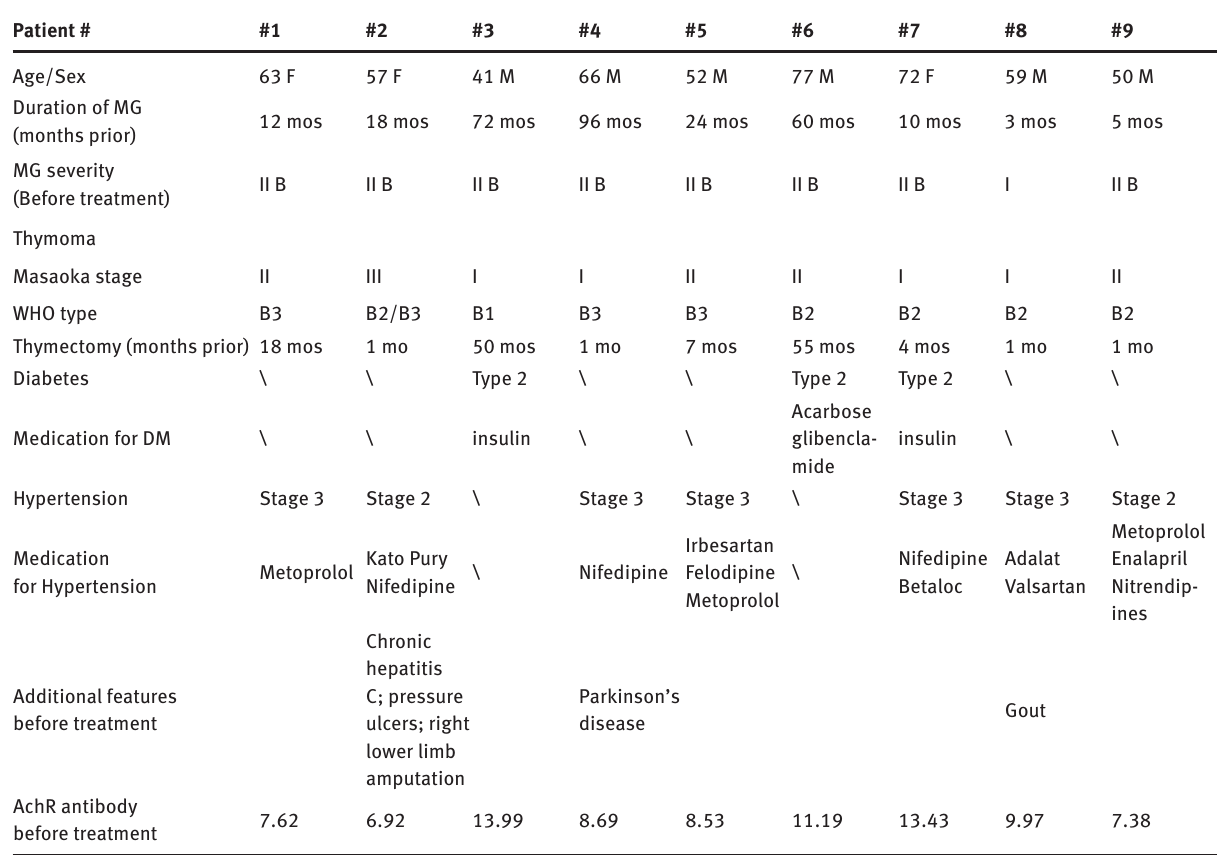
Table 1: Characteristics of patients before docetaxel/cisplatin